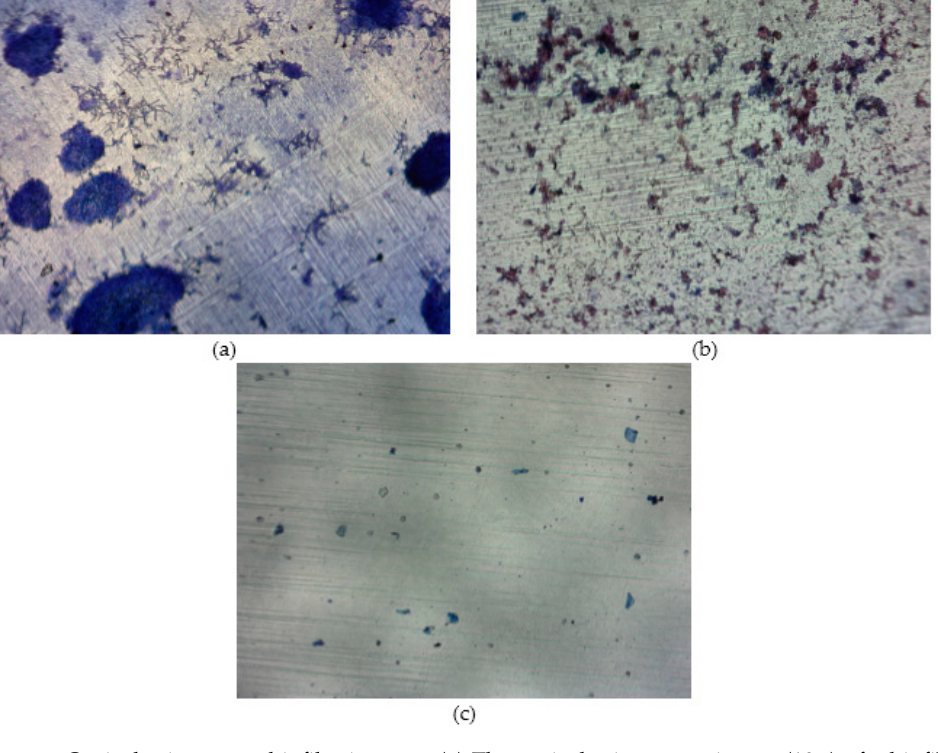
Figure 5. Optical microscope biofilm images. ( a ) The optical microscope image (10 × ) of a biofilm produced by C. albicans on Bialecki ring (25 × 25). ( b ) The optical microscope image (10 × ) of a biofilm produced by C. subhashii on Bialecki ring (25 × 25). ( c ) Control image: clean Bialecki ring (25 × 25).